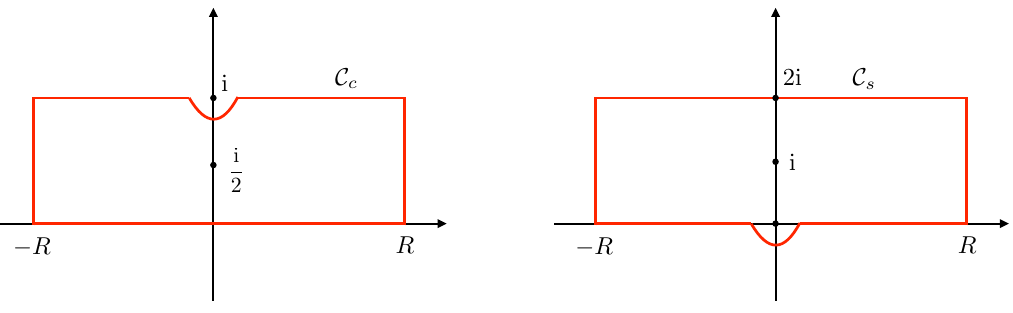
Figure 17 . Integration contours for the calculation of the integrals (B.34). They are oriented coun-